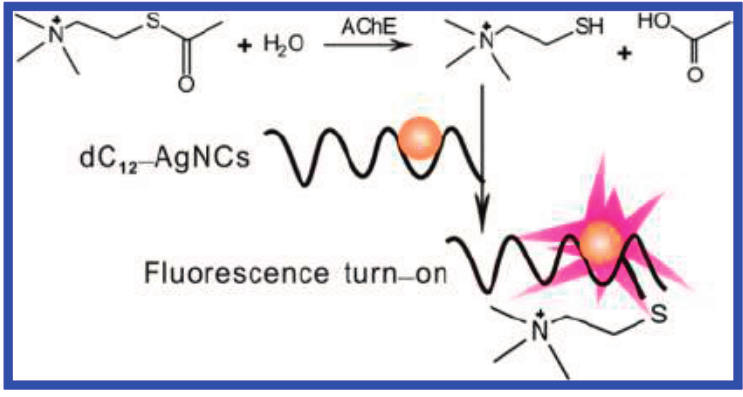
Figure 6. Principal reactions of fluorescence assay for AChE activity. Reprinted with permission from [55]. Copyright 2013 American Chemical